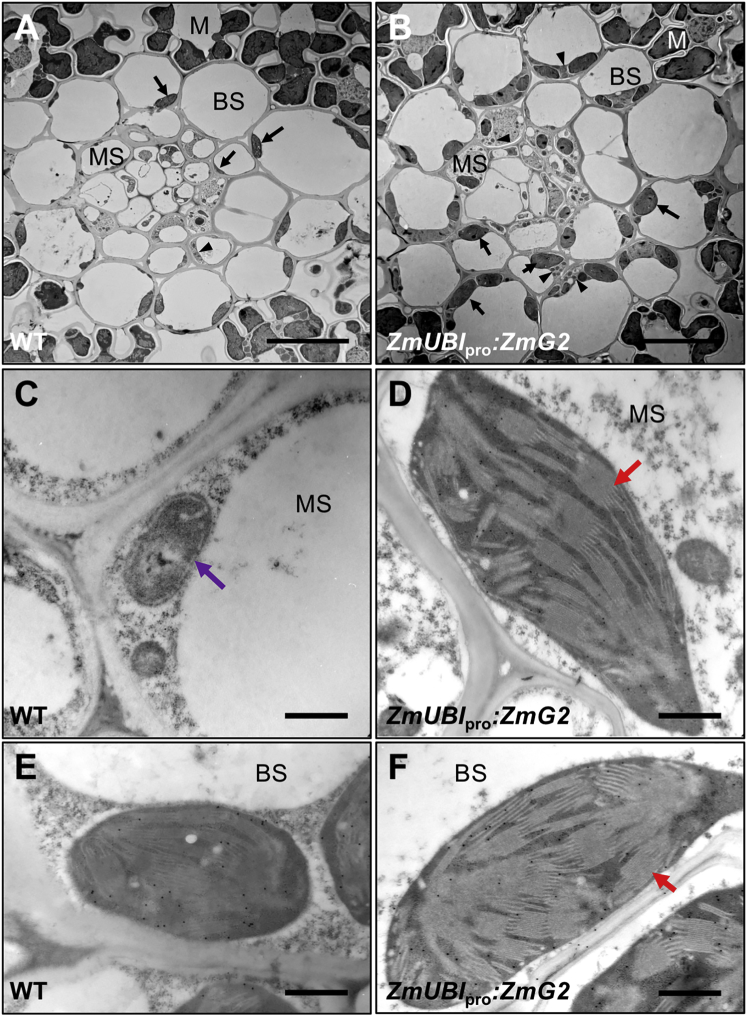
Chloroplasts in Both Bundle Sheath and Mestome Sheath Cells of Lines that Constitutively Express ZmG2 Accumulate Photosynthetic Enzymes(A and B) Transmission electron micrographs of minor veins in leaf 7 of wild-type (WT) (A) and ZmUbipro:ZmG2 transgenic (B) plants grown at 300 μmol photons m−2 s−1. The position of bundle sheath (BS), mestome sheath (MS), and mesophyll (M) cells is indicated, with arrows pointing to representative chloroplasts and arrowheads pointing to mitochondria in each cell type.(C–F) Transmission electron micrographs of WT (C and E) and ZmUbipro:ZmG2 transgenic (D and F) lines showing plastid ultrastructure and immuno-gold labeling with RuBisCo antibody in MS (C and D) and BS (E and F) cells. Purple arrow, proplastid; red arrows, organized thylakoid stacks.Scale bars, 2 μm (A and B) and 500 nm (C–F). See Table 1 for quantification of immuno-gold labeling and Figure S3 for immuno-labeling with additional enzymes. See also Figures S1 and S2 and Tables S1 and S3.